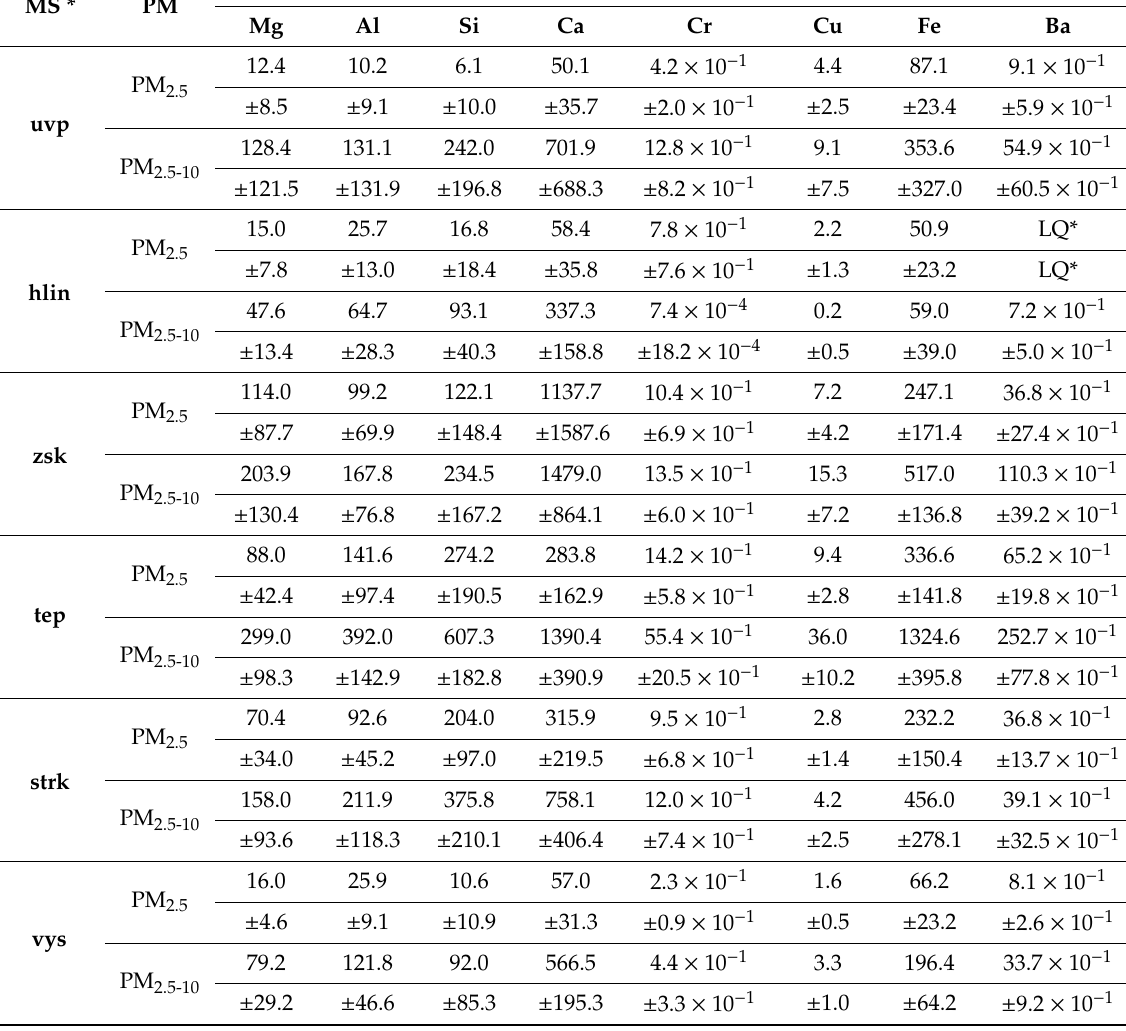
Table 1. Average concentration of elements in the particulate matter (PM) fraction (PM 2.5 and PM 2.5-10 ) at di ff erent measuring stations, with more than 60% in the PM 2.5-10. Average Concentration ± Standard Deviation [ng / m 3 ] of the Element in the PM